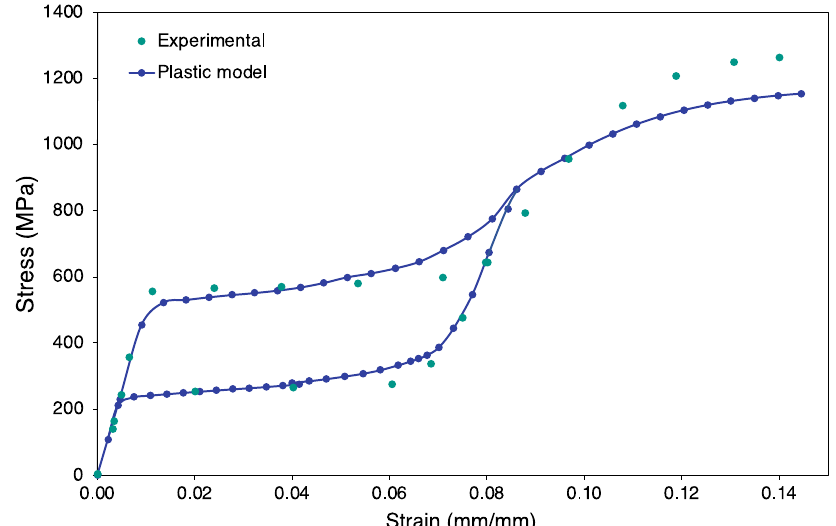
Figure 12. Discrete superelastic model and plastic model simulated results.